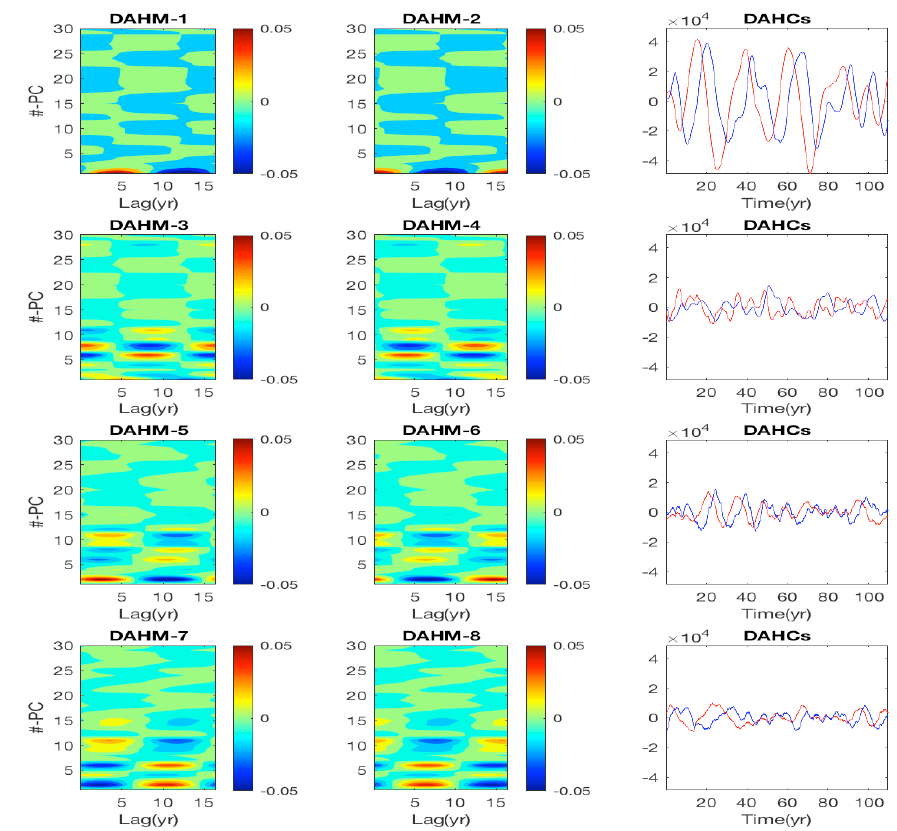
Figure 3. Left and center panels: Space-time patterns of data-adaptive harmonic mode (DAHM) pairs corresponding to the four largest | λ j | (in descending order) at decadal frequency f = 0.061 y − 1 (cyan dots in the data-adaptive harmonic (DAH) power spectrum of Figure 2). Each of the modes in a pair is time-shifted by a quarter of a period, i.e., in exact phase quadrature; x -axis, time embedding dimension (in years); y -axis, spacial dimension (rank of principal component (PC)). Right panels: DAHCs obtained by projection of the input dataset of 30 PCs onto the DAHMs; see (20). A DAHC pair consists of narrowband time series at the same temporal frequency of the associated DAHMs, but modulated in